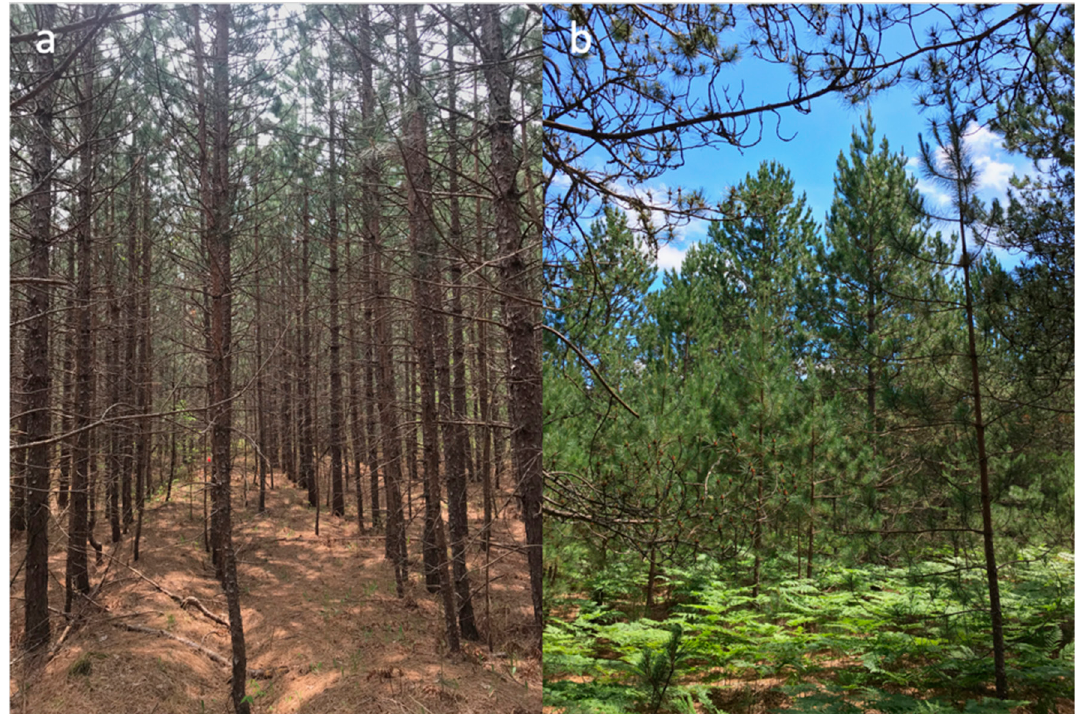
Figure 1. Planted 25-year-old ( a ) and naturally regenerated 20-year-old ( b ) red pine ( Pinus resinosa ) stands in north Michigan, USA. Planted stands are more structurally uniform, with relatively even stem spacing and heights, along with high stem densities. Naturally regenerated stands are uneven-aged, more sparsely vegetated, and contain trees varying in height.